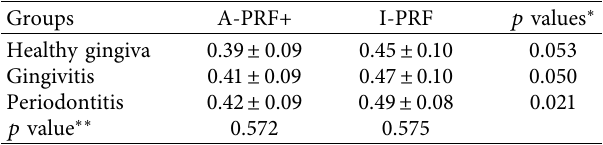
Table 1: Demographic data. Table 2: Bioflm inhibitory assay: the percent reduction in the number of bacteria (%) compared to the control under the in- fuence of diferent blood-derived products (A-PRF+ and I-PRF) from the three